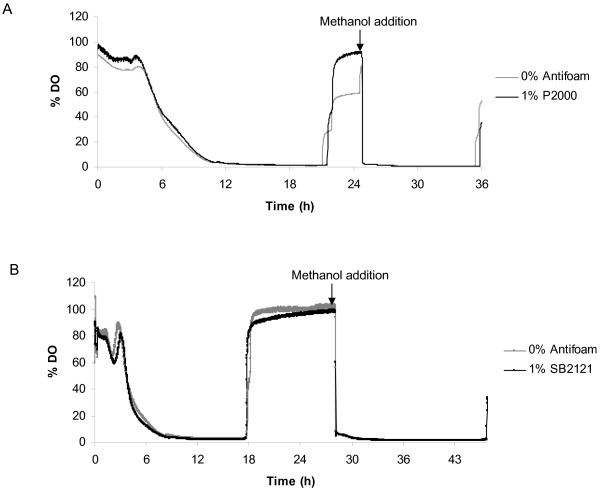
P2000 and SB2121 do not affect DO in shake flasks. Addition of 1% P2000 (A) or 1% SB2121 (B) did not affect the DO in shake flasks, as determined by DO fluorescent sensors (PreSens) attached to the underside of each flask. The experiments in panels A and B are biologically independent, which is the origin of the clonal differences and the variations in technical additions.